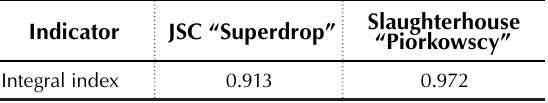
Table 3. The results of calculation of integral